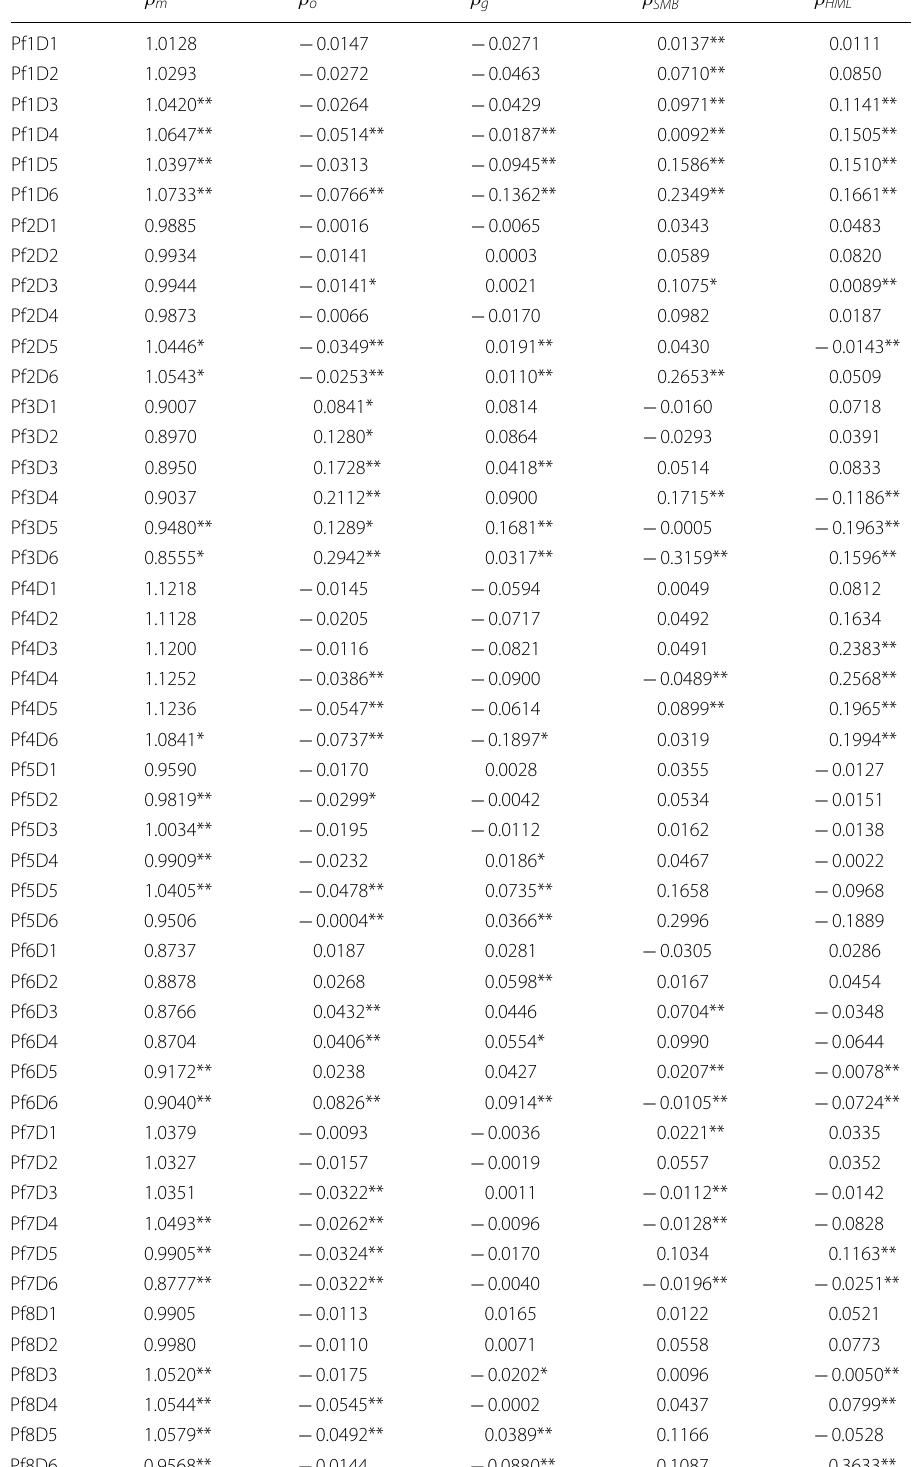
Table 6 Time–Frequency sensitivities of Portfolios compared to Standard Multi Beta